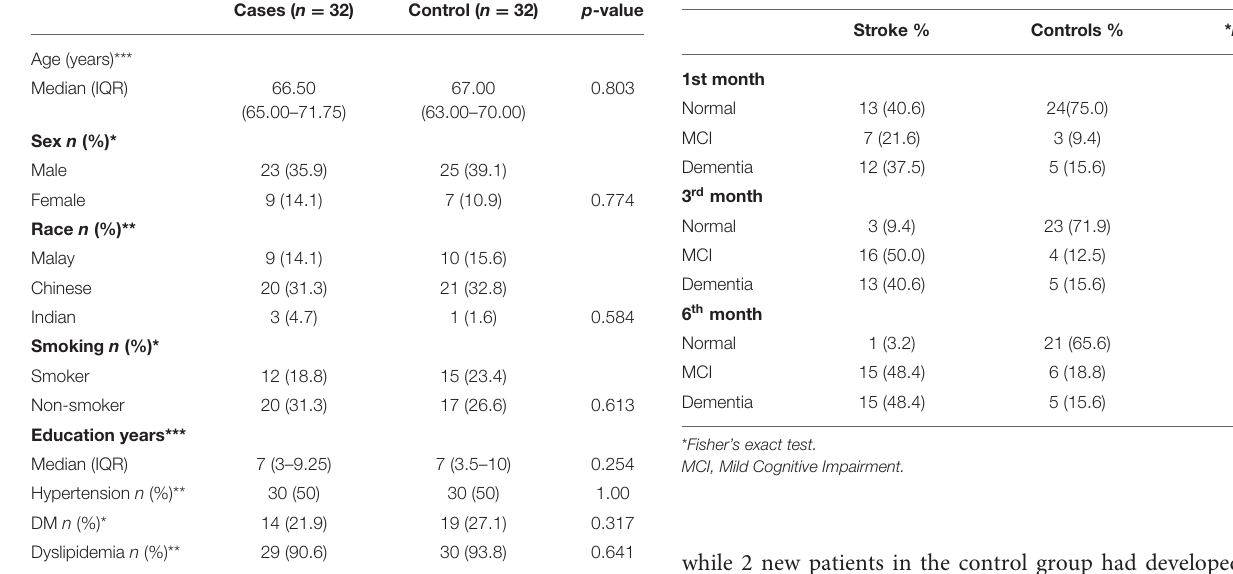
TABLE 2 | Frequency of PSCI (MCI and dementia) among stroke subjects and controls. Stroke % Controls